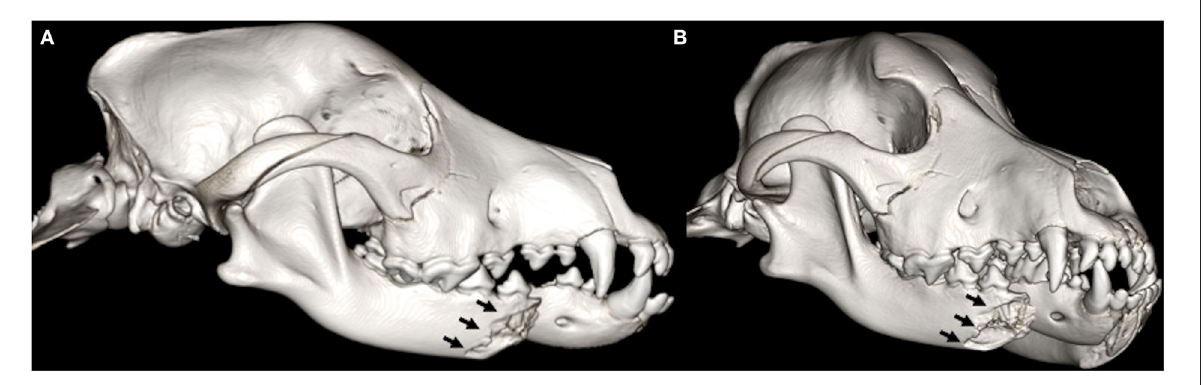
FIGURE5 3D-rendered right lateral (A) and oblique (B) CBCT images of the skull of an 8-month-old Labrador retriever dog. Note the complete fracture with severe displacement of the right premolar area of the mandible (arrows).